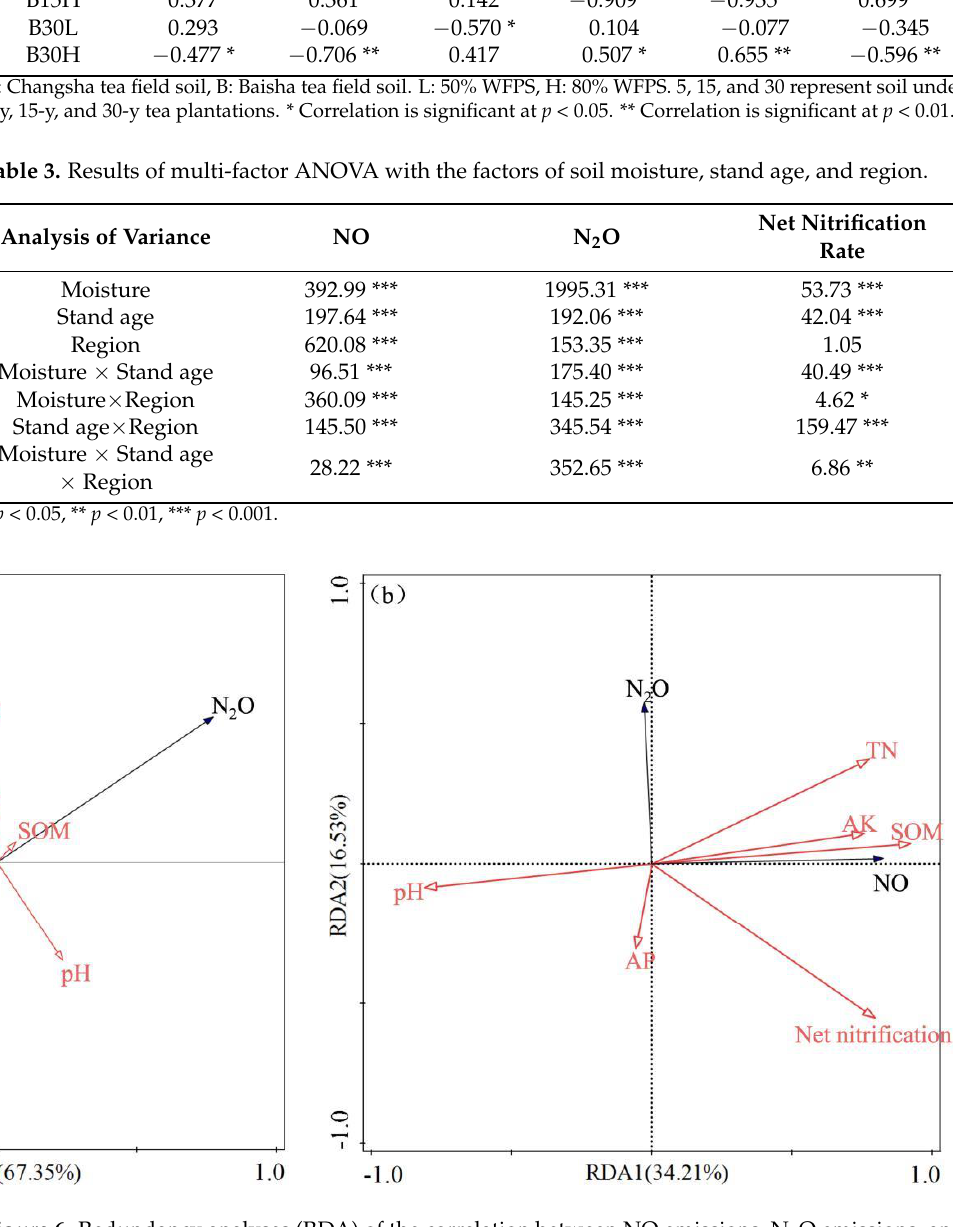
Figure 6. Redundancy analyses (RDA) of the correlation between NO emissions, N 2 O emissions, and soil properties in ( a ) Changsha tea field soil and ( b ) Baisha tea field soil.